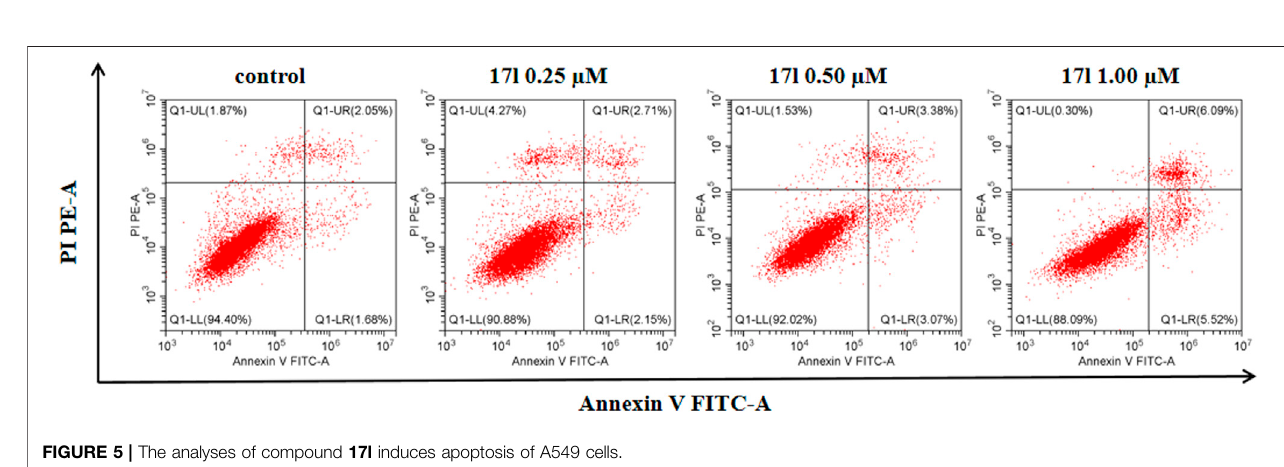
foretinib as positive control. Table 1 shows the results, and all the values were averages of two independent experiments. As shown